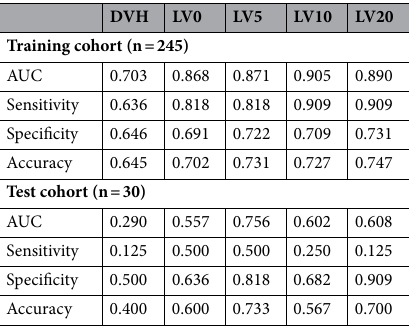
Table 2. AUCs, sensitivity, specificity, and accuracy of the ensemble averaging model for training and test cohorts.